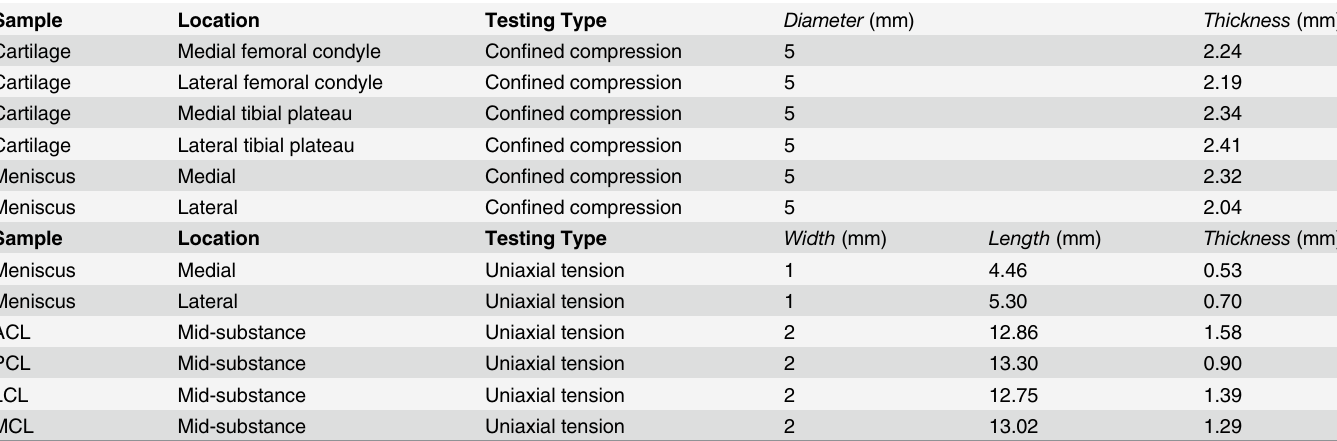
Table 1. Details of the locations and dimensions for all samples for mechanical tissue testing.